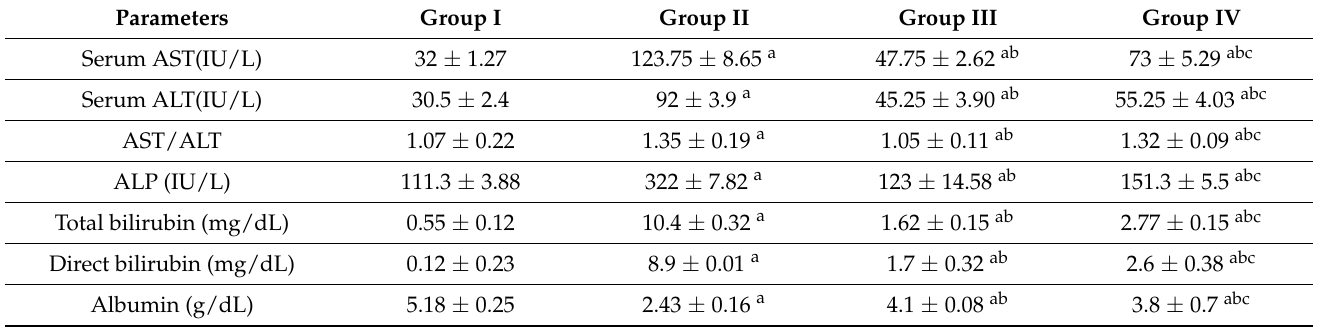
Table 1. Effect of carvedilol on liver function in hepatic ischemia associated with isoprenaline-induced